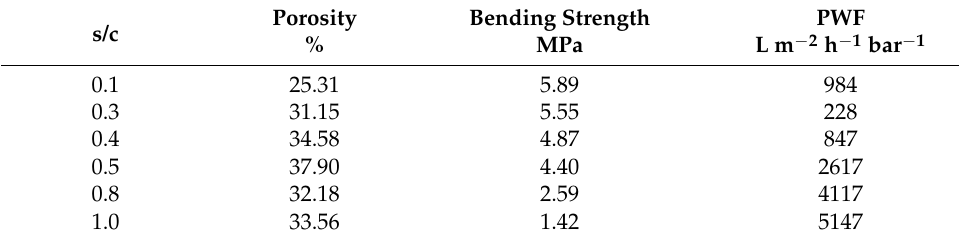
Table 2. Effect of s/c on membrane properties: porosity, bending strength, and PWF.